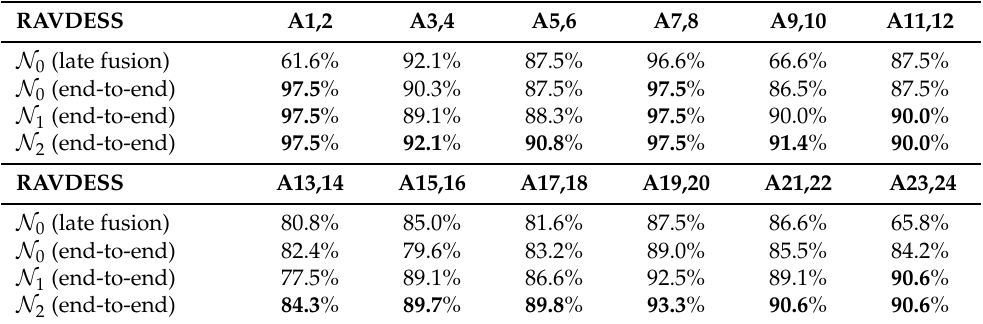
Table 2. Comparison for RAVDESS of MRPN approach (network N 2 ) with late fusion strategy ( N 0 ),